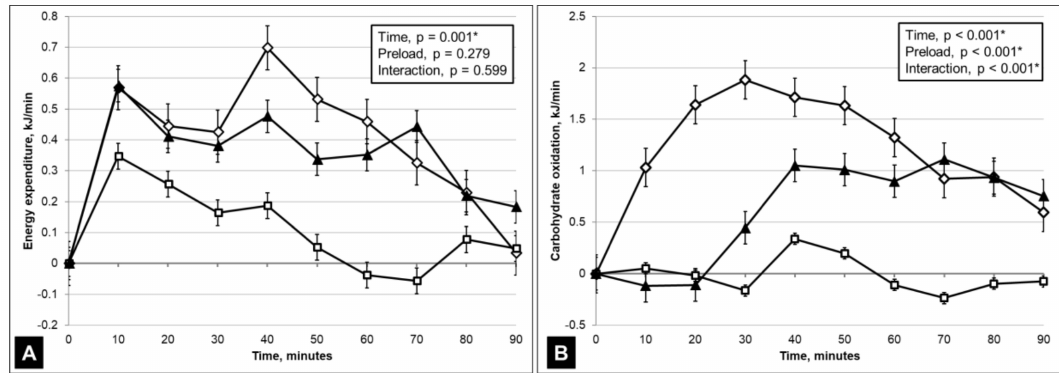
Figure 2. Temporal changes in energy expenditure ( A ) and carbohydrate oxidation ( B ) from resting values over 90 min following the ingestion of three sweet test foods. Values are presented as changes from baseline as means of n = 11 participants, and error bars represent standard errors (SE): Diamonds ( ♦ )—SUCROSE (test food with 50g sucrose); triangles ( (cid:78) )—MALT (test food with 120mg sucralose and 50g maltodextrin)squares ( (cid:3) )—NNS (test food with 120mg sucralose only);. * Statistically significant, general linear model for repeated measures ANOVA, p < 0.05.